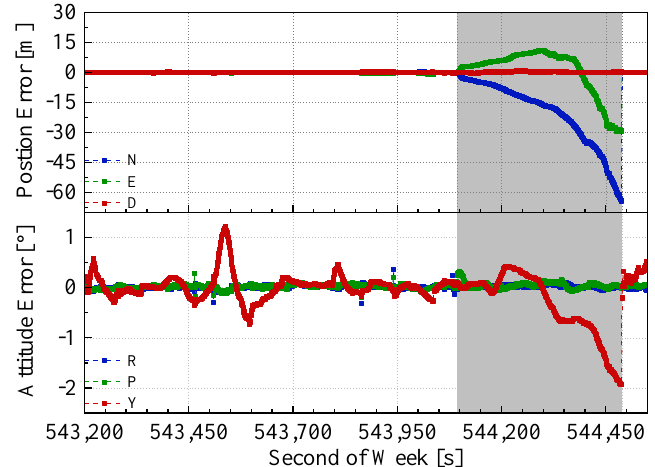
Figure 12. GNSS / INS / ODO navigation errors in the East Lake Tunnel Figure 12. GNSS/INS/ODO navigation errors in the East Lake Tunnel test.